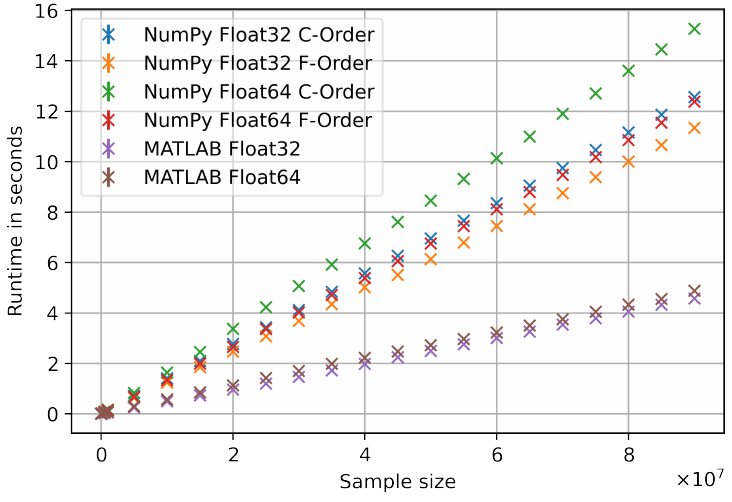
Figure 6. Statistical tolerance analysis using CPU: Mean runtime results with error bars. Table 7. Statistical tolerance analysis using CPU: Mean runtime results in seconds with standard error of the mean. Sample